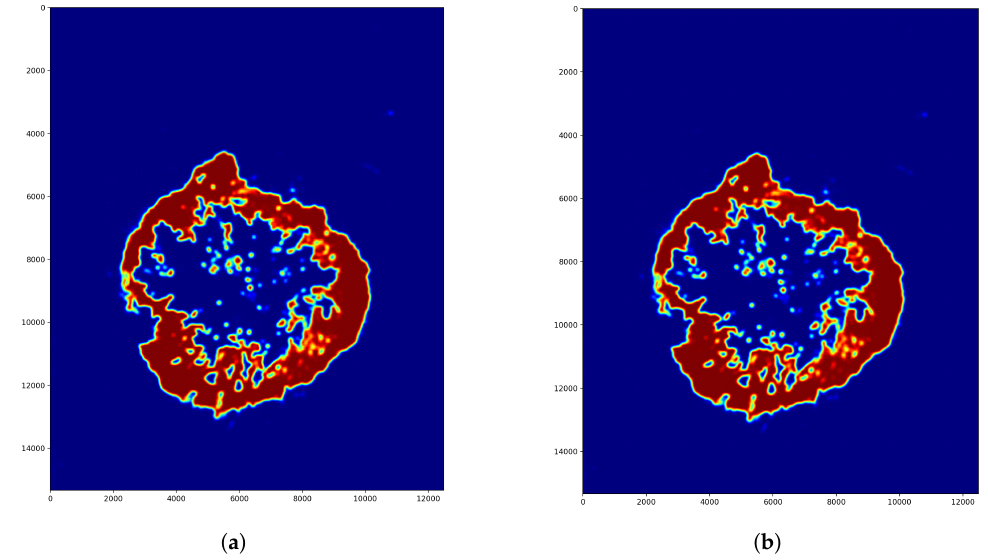
Figure 10. Parameter searching for the optimal overlapping step size. ( a ) Step size = 32 pixels. Pixel value averaged from 16 predictions. ( b ) Step size = 8 pixels. Pixel value averaged from 256 predictions.